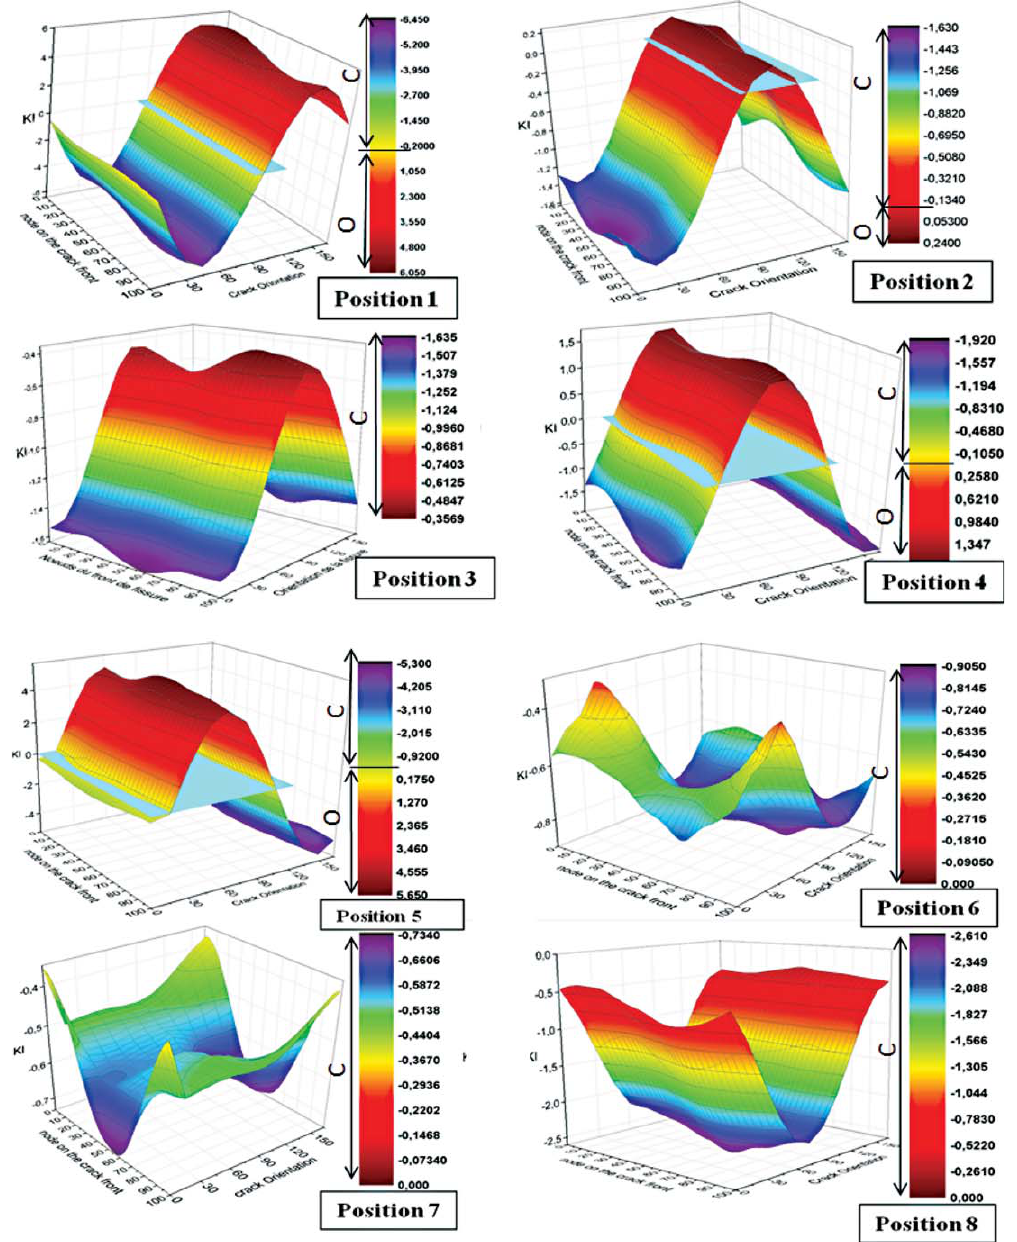
Fig. 17. K I comparison for different crack locations (C: indicates the crack closing range and O: indicates the crack opening range).